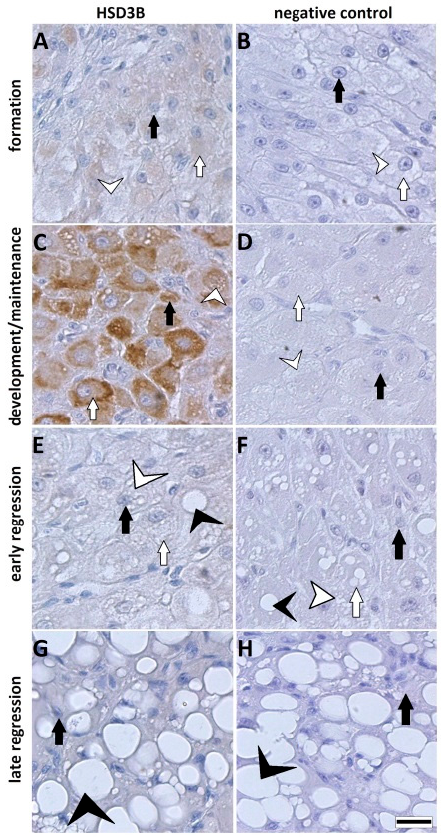
Figure 4. Immunohistochemical staining for HSD3B ( A , C , E , G ) and negative control ( B , D , F , H ) in CL from the domestic cat at different developmental stages. HSD3B protein signal was detected in a cytoplasm of SLC and LLC. Scale bar is equal to 20 µm.